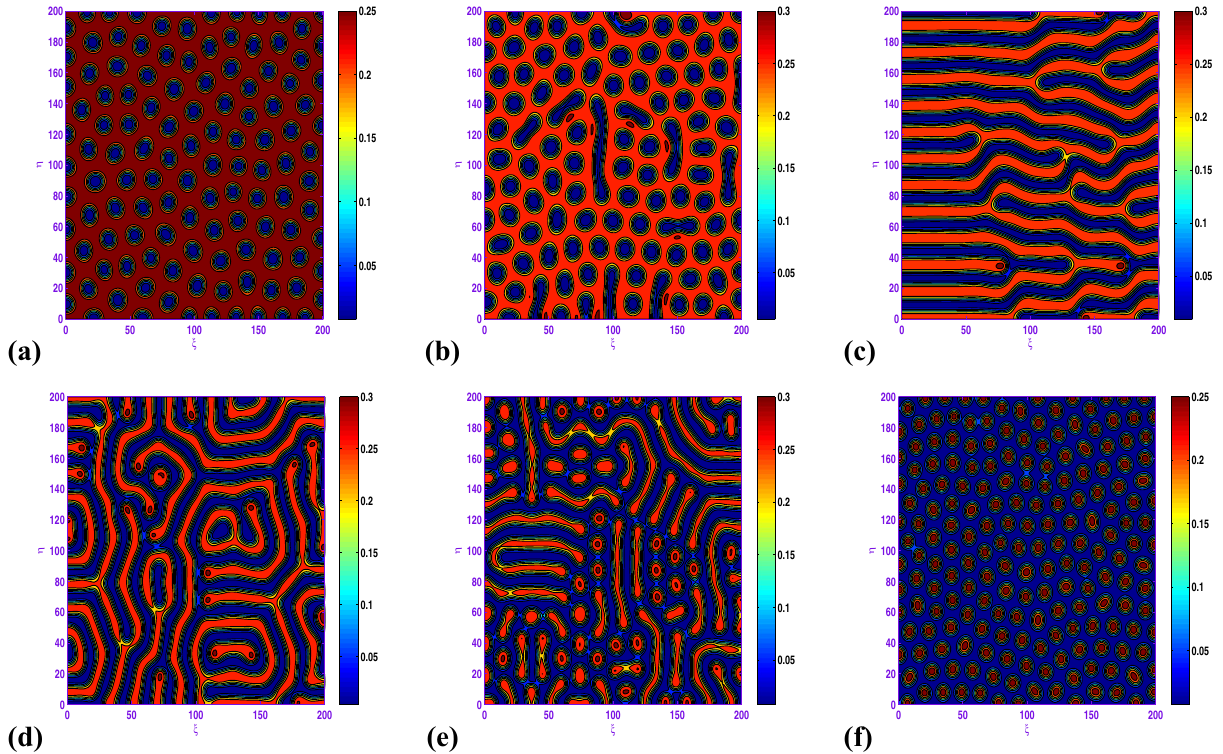
Figure 12. Transition of spatial dynamics of the prey population ( u ) in the model (15) at t = 5000 , for the set: a = 2.1 , b = 3.01 , d = 0.2 , d 1 = 0.1 , d 2 = 20.0 and ( a ) β = 4.8 ; ( b ) β = 4.9 ; ( c ) β = 5.1 ; ( d ) β = 5.2 ; ( e ) β = 5.4 ; ( f ) β = 6.0